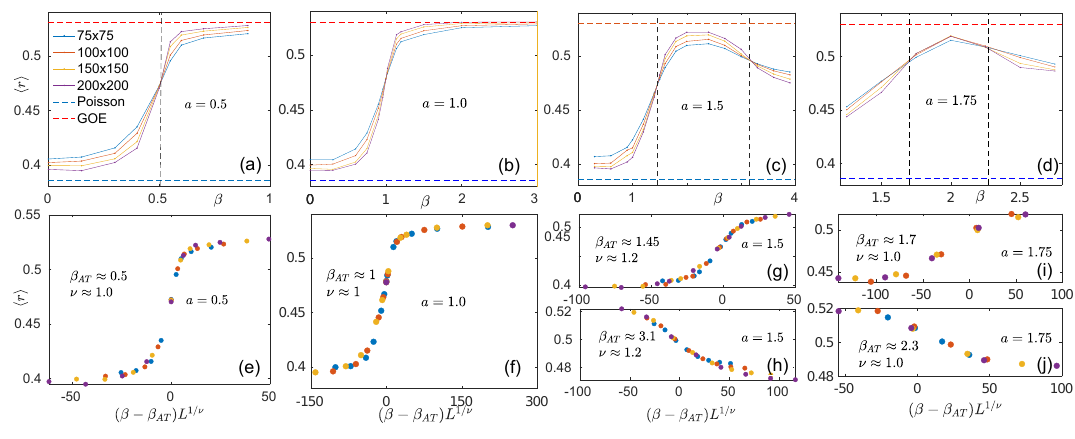
Figure 3: Spectral-averaged ratio r -statistics versus the anisotropy parameter β . Level statistics, averaged over the spectral bulk E ∈ [ − W / 2, W / 2 ] , versus anisotropy β at (a) a = 0.5, (b) a = 1.0, (c) a = 1.5, and (d) a = 1.75 for the disorder strength W = 20 and different system sizes L = 75, 100, 150, and 200 (shown in legend) with the corresponding number of disorder realizations 2000, 2000, 1000, and 400, respectively. Dashed horizontal lines show the limiting ergodic ( r (cid:39) 0.53) and Pois- son ( r (cid:39) 0.386) values. The vertical lines show the extracted anisotropy parameter β at the localization transition. Panels (e-j) show the finite-size collapse of all 6 AT (cid:2) ( β − β ) L 1 /ν (cid:3) , with critical values β crossing points using 〈 r 〉 = R and critical AT AT exponents ν